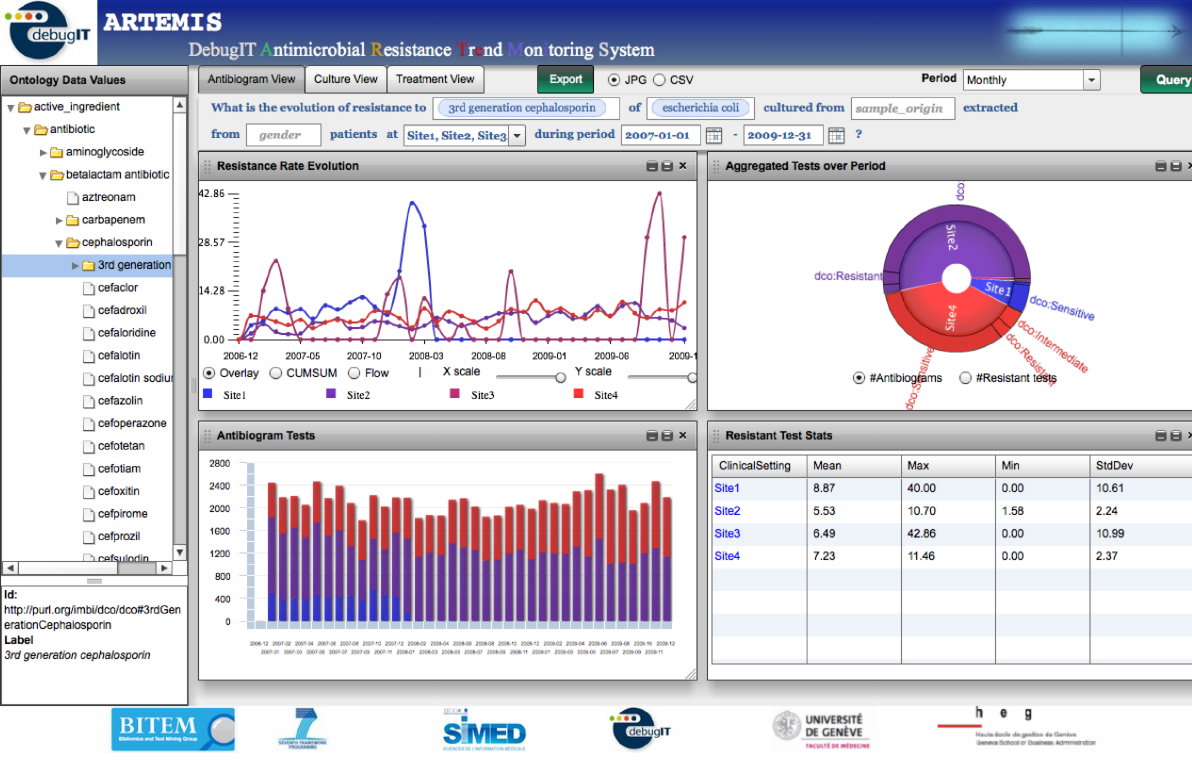
Figure 3. Antimicrobial Resistance Trend Monitoring System (ARTEMIS) interface. The menu on the left displays the interface ontology concepts, which are used to fill in the template parameters. Each of the view tabs represents a different query template. The data visualization interface displays several graphical representations to provide a comprehensive view of the